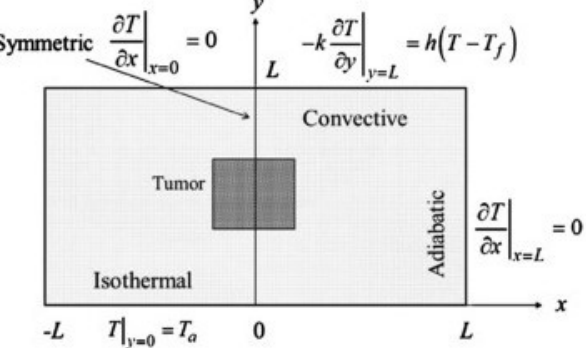
Figure 3. The rectangular area that provided the first glimpse of predictive models that relate surface temperature to tumor size and location [23].